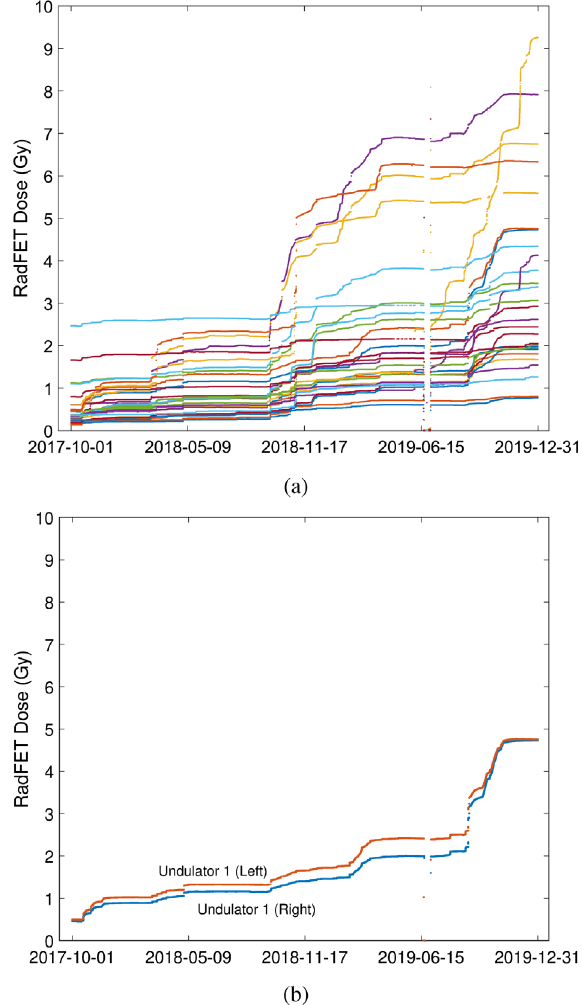
8. (a) Doses accumulated by all RadFETs installed around the Aramis undulators, plotted once every hour. The maximum dose of 9.26 Gy was accumulated by a RadFET at the entrance of the ninth undulator. (b) Dose accumulated by RadFETs installed at the entrance of the first undulator, plotted once every